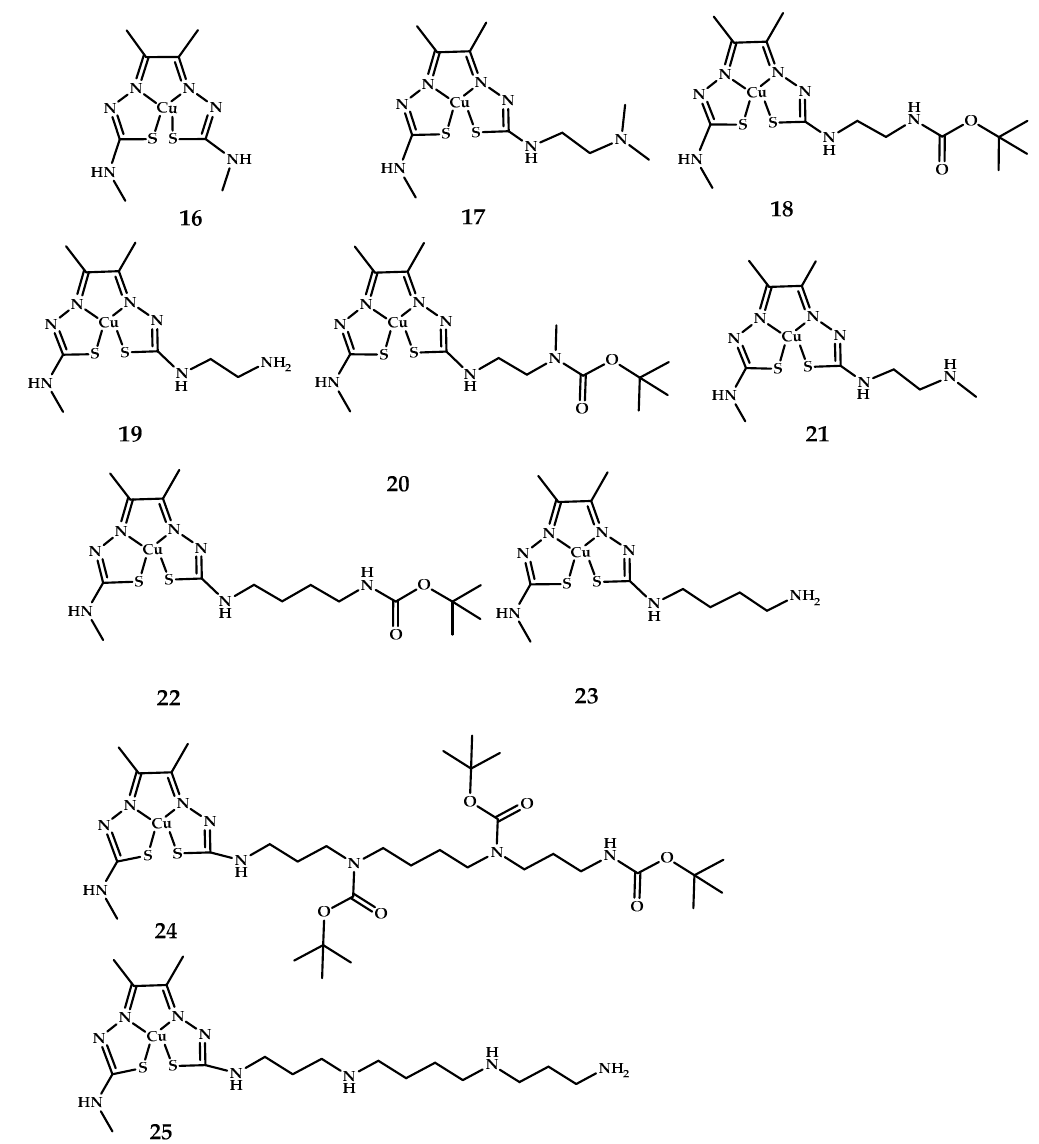
Figure 7. Cu(II)-ATSM derivatives conjugated with polyamines 16 – 25 , designed for A β Figure 7. Cu(II)–ATSM derivatives conjugated with polyamines 16 – 25 , designed for A β fibrils fibrils visualization.